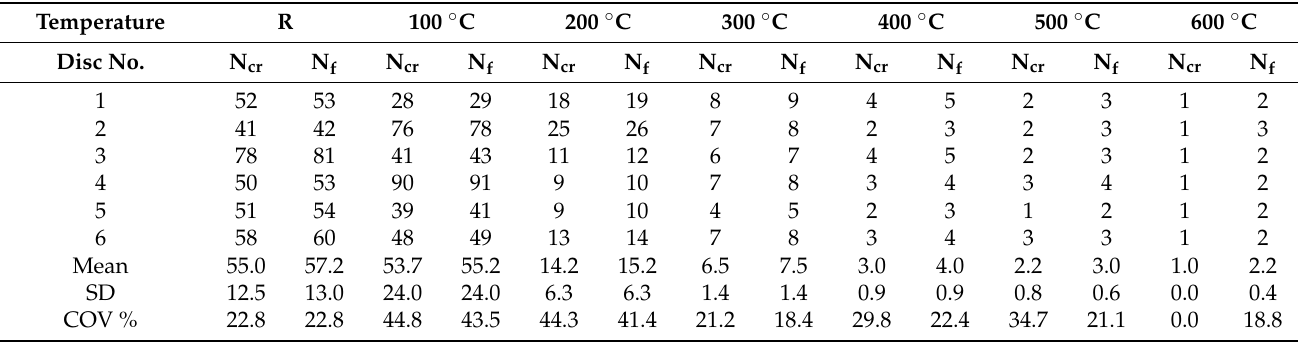
Table 2. Results of repeated impact